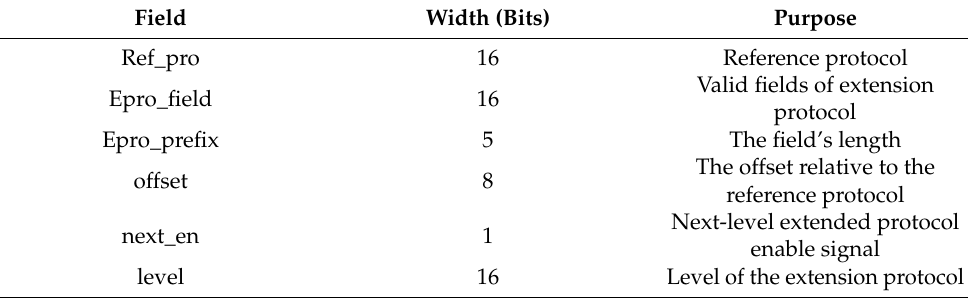
Table 2. Extended protocol